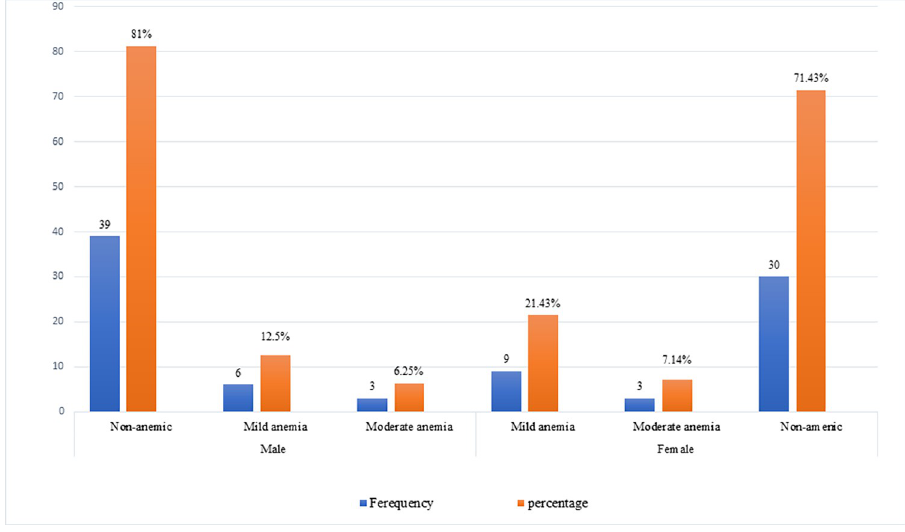
Fig 2. Severity of anemia among S . mansoni infected patients: The first chart indicate the severity amnemia among males while the last three chart indicate anemia severity in females. The blue chart indicate the frequency and the red indicate the percent of